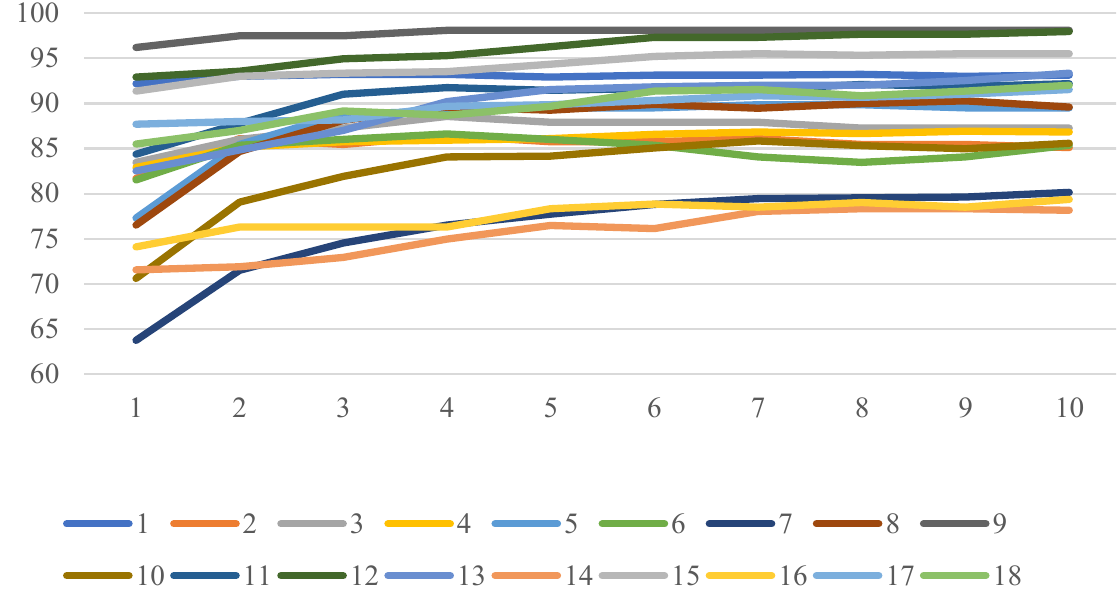
Figure 4. Performance during training. X-axis: training process. Y-axis: accuracy.